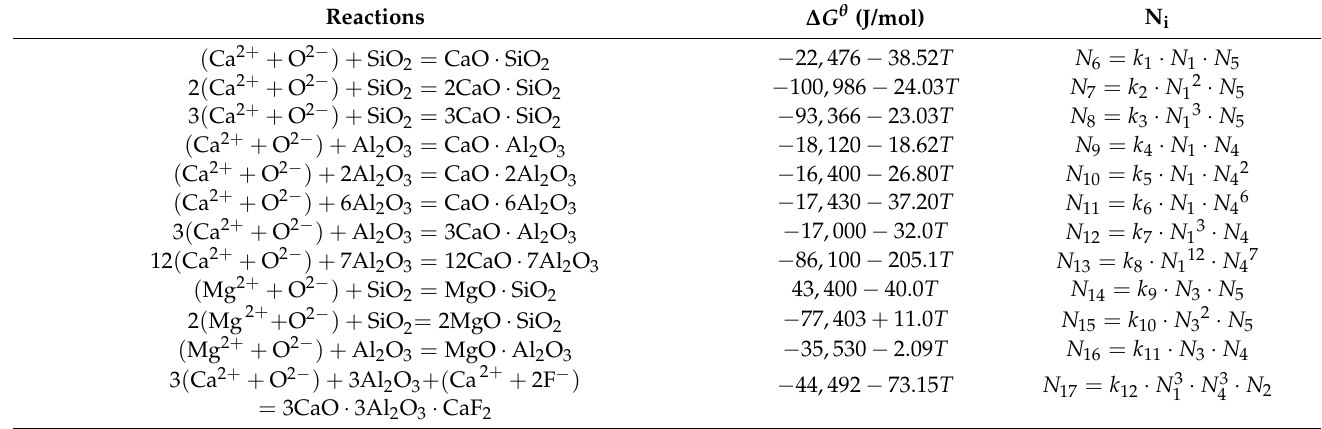
Table 8. Potential complex molecular reaction formulae in CaO-MgO-SiO 2 -Al 2 O 3 -CaF 2 slags.